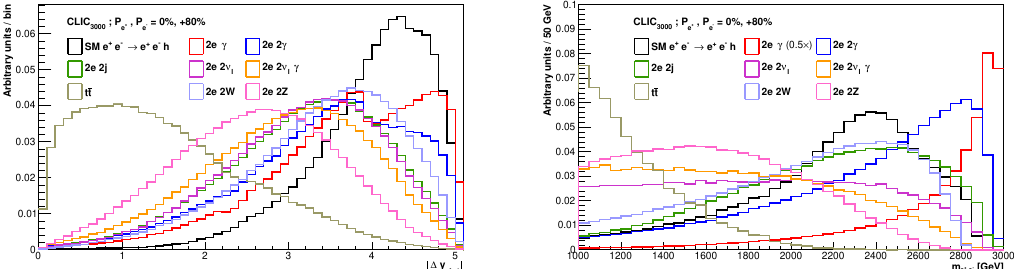
Figure 5. Some plots of the CLIC 3000 ZBF selection with the right polarisation for the SM-driven e + e − → e + e − h (black), 2 eγ (red), 2 e 2 γ (blue), 2 e 2 j (green), 2 e 2 ν ‘ (magenta), 2 e 2 ν ‘ γ (orange), tt (brown), 2 e 2 W (lilac), and 2 e 2 Z (pink) processes. All histograms are normalised to unity. Left: | ∆ y | distribution, showing the forward nature of the e + e − → e + e − h single-Higgs production e + e − process at high energies. Right: m distribution before requiring m ∈ [2100 . 0 , 2880 . 0] GeV. e + e − e + e − The 2 eγ histogram in the right panel is scaled ( 0 . 5 × ) after normalisation for visualisation purposes. Note that, although the Zh and ZBF diagrams interfere with each other, at high energies the t - channel ZBF dominates over its s -channel counterpart Zh .